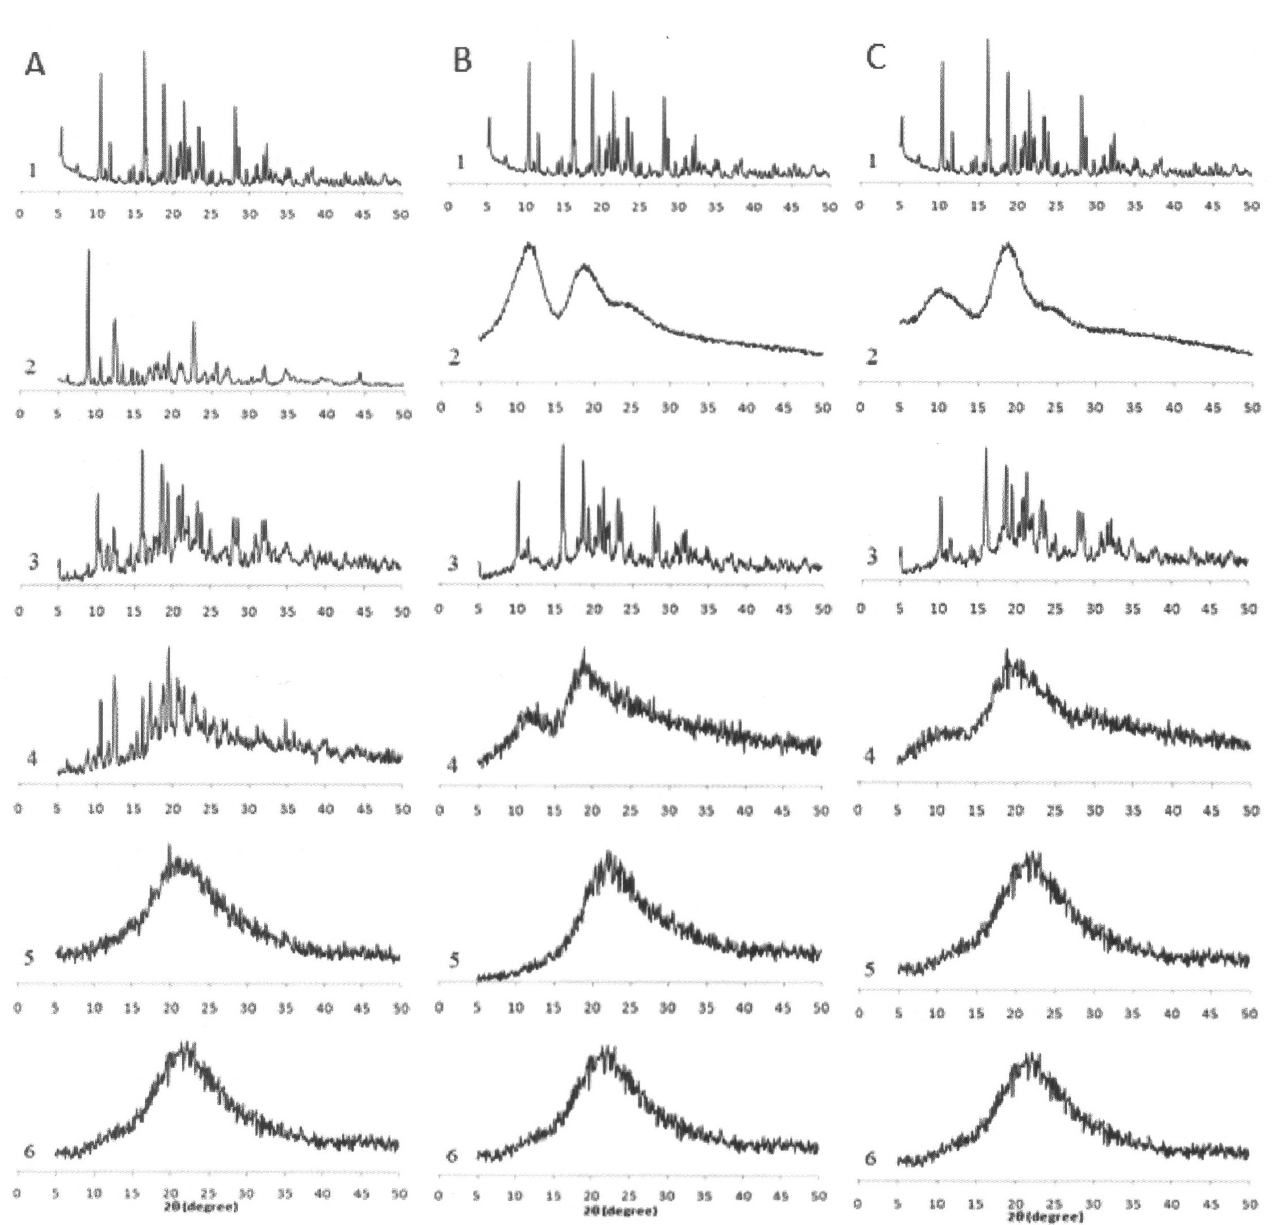
FIGURE 2 - X-ray diffractograms corresponding to: (A): 1 – AMH, 2 - β-CD, 3 – AMH/β-CD/PM, 4 – AMH/β-CD/CE, 5 – AMH/β- CD/SD, 6 – AMH/β-CD/FD, (B): 1 – AMH, 2 - Methyl-β-CD, 3 – AMH/Methyl-β-CD/PM, 4 – AMH/Methyl-β-CD/CE, 5 – AMH/ Methyl-β-CD/SD, 6 – AMH/Methyl-β-CD/FD and (C): 1 - AMH, 2 - HP-β-CD, 3 – AMH/HP-β-CD/PM, 4 – AMH/HP-β-CD/CE, 5 – AMH/HP-β-CD/SD, 6 -